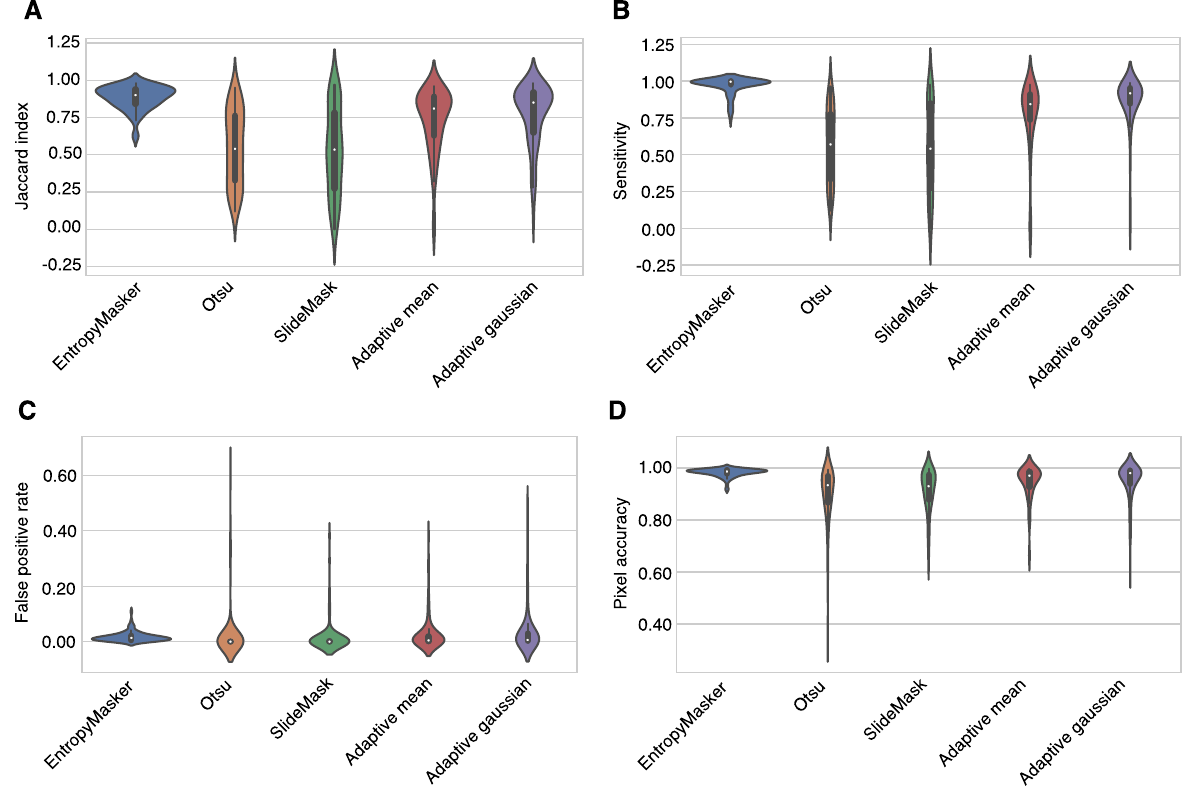
Figure 2. Evaluation metrics for different masking methods. Comparison of EntropyMasker with other masking methods: Otsu, slideMask, and adaptive thresholding methods, using manually annotated tissue sections as ground truth. 97 images from 59 individual patient samples were randomly selected and used to evaluate each method by calculating the ( A ) Jaccard index (intersection over union metric), ( B ) sensitivity, ( C ) false positive rate, and ( D ) pixel